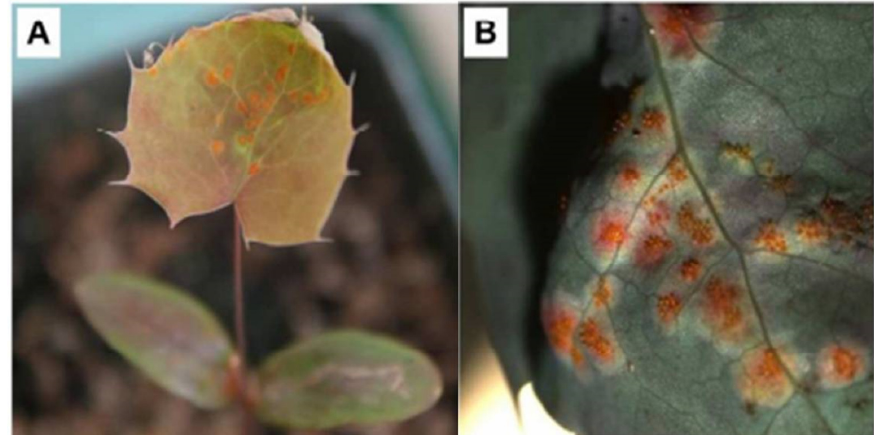
Fig. 4. Disease symptoms on Oregon grape ( Mahonia aquifolium ): pycnia (A) and aecia (B) produced on the upper and lower side of leaves respectively (Wang et al. ,